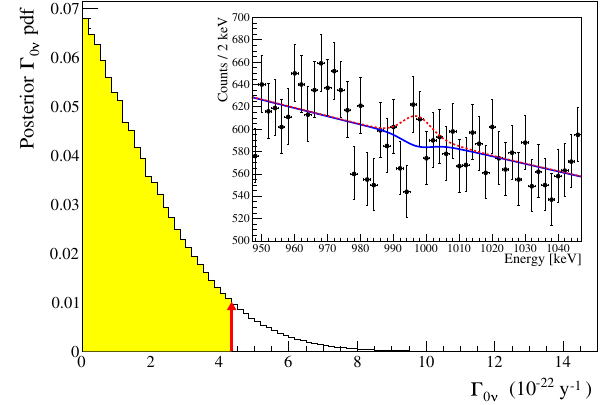
Fig. 2 Posterior p.d.f. of the decay rate of 70 Zn. The 90% integral of the posterior is highlighted in yellow, and the red arrow indicates the valueofthedecayratecorrespondingtothe90%credibleinterval.Inset: fit of the experimental data in a ± 50keV region centred around the Q value. Dotted line: a hypothetical signal corresponding to the 90% CI limit set in this